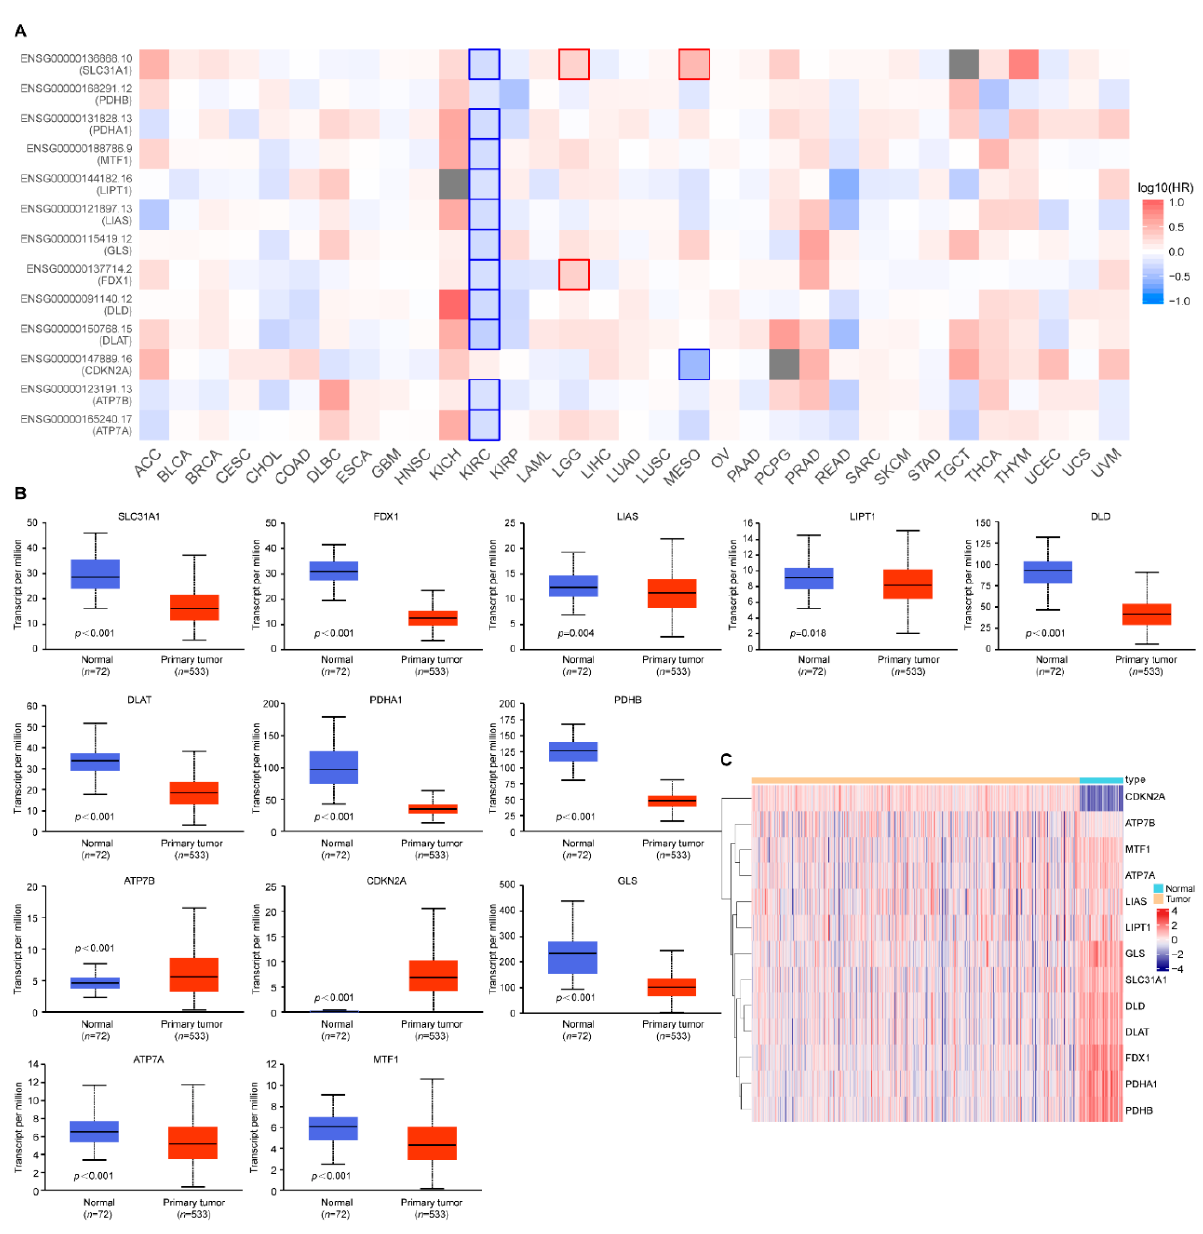
Figure 1. Cuproptosis-related gene expression in ccRCC and its prognostic relevance in pan-cancers. ( A ) The prognostic relevance of cuproptosis-related genes in pan-cancers; ( B ) The expression pattern of cuproptosis-related genes in ccRCC; ( C ) Heatmap plots of cuproptosis-related genes between ccRCC samples and adjacent normal samples. Red denotes upregulated genes, and blue denotes downregulated genes in heatmaps. The horizontal axis of the heatmaps represents the samples. p values less than 0.05 were considered to be statistically significant.